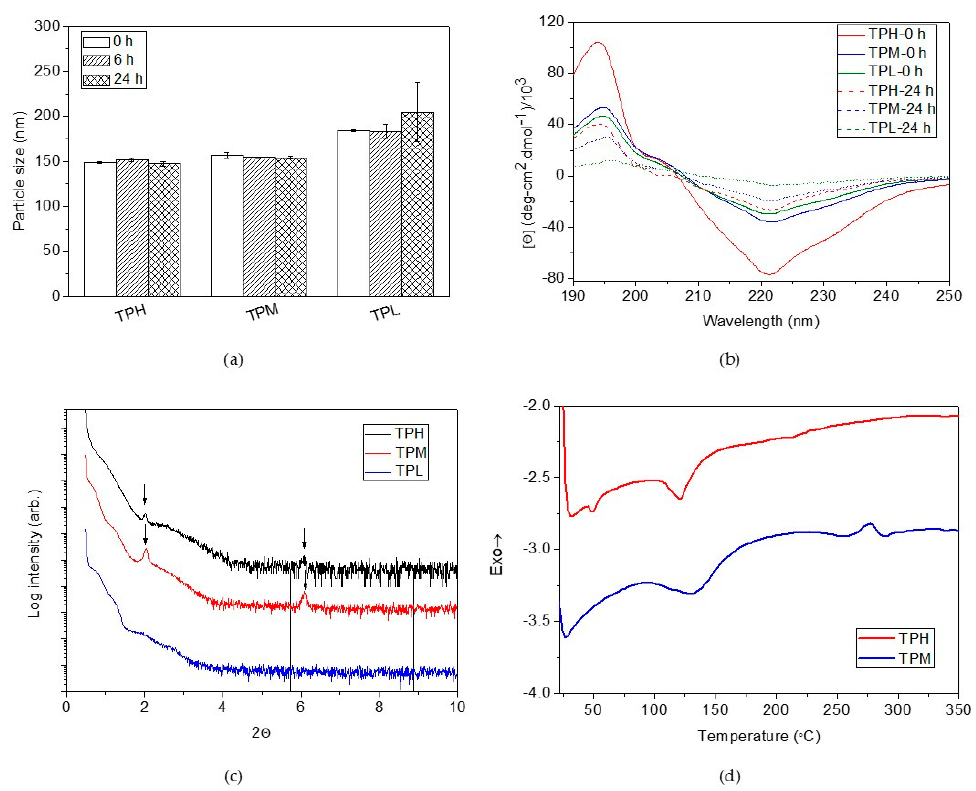
Figure 1. Stability tests of the mixed micelles incubated at 37 °C. ( a ) The changes of particle sizes and distribution at both 6 h and 24 h. ( b ) The CD spectrum of micelles at 24 h for determination of the secondary structures of the mixed micelles. ( c ) The XRD pattern and ( d ) differential scanning calorimetry analysis of micelles for crystalline alignment evaluation.